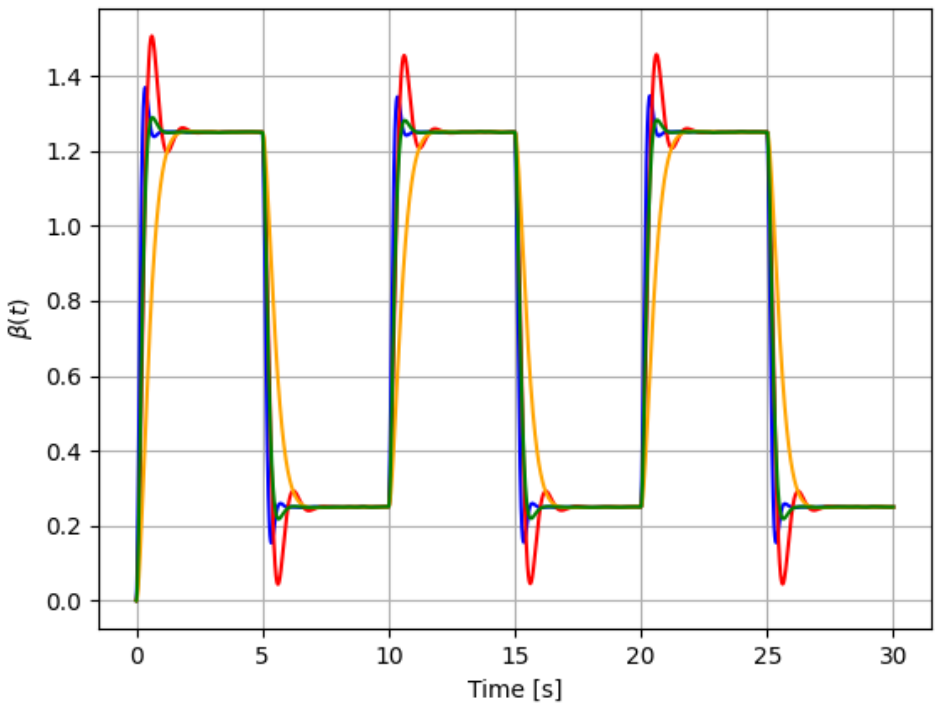
Figure 3. First simulation: pitch actuator responses for each case in Table 1: H (blue), F 1 (red), F 2 (orange), and F 3 (green). The command signal is the one in Figure 2.